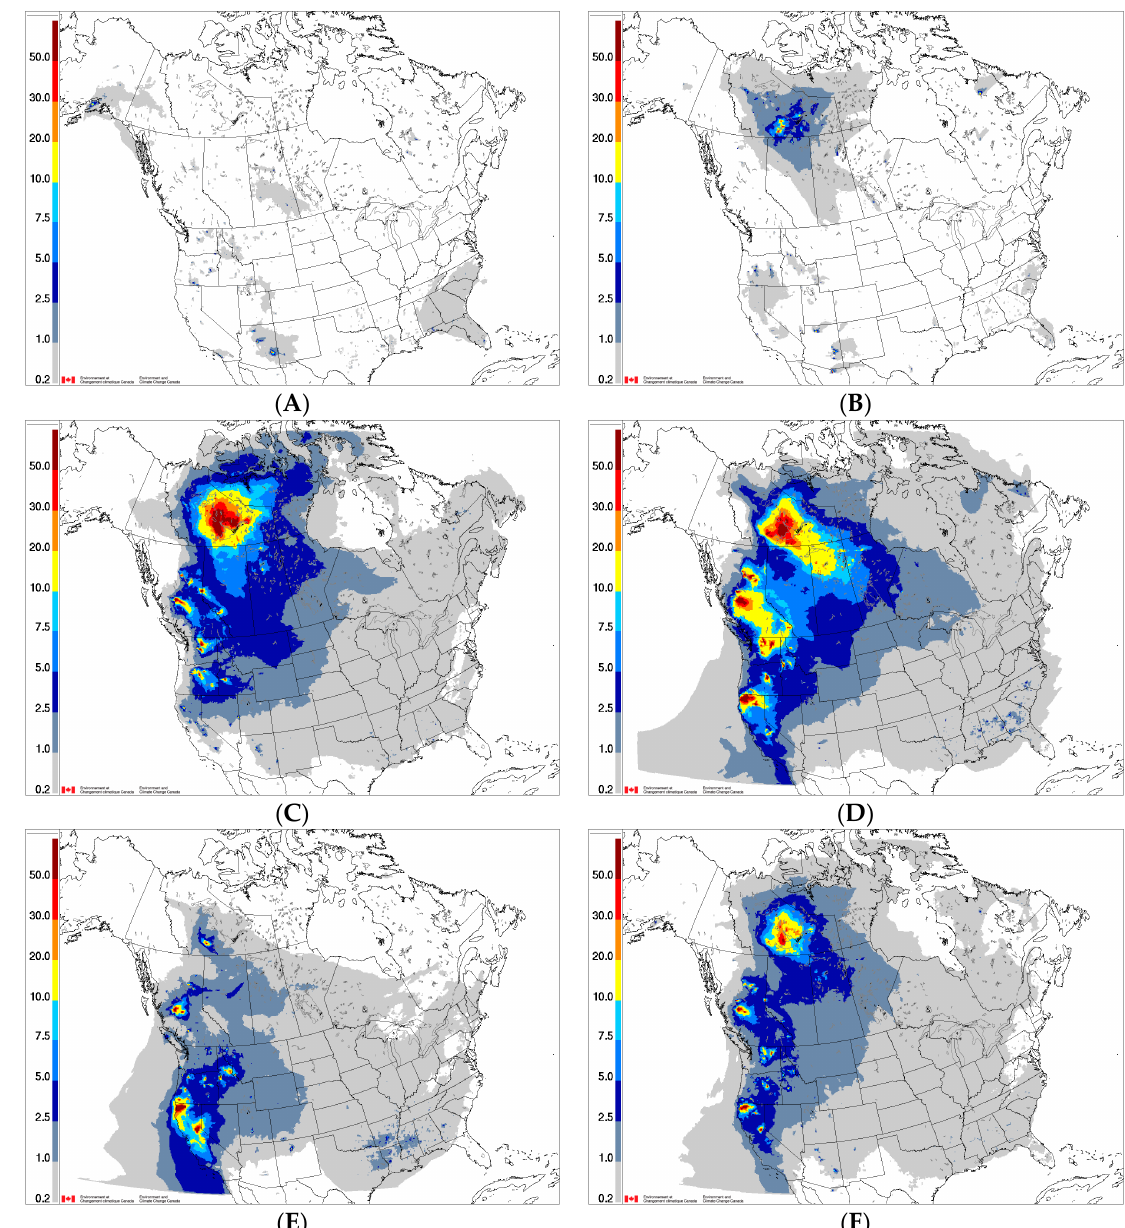
Figure 4. Same as Figure 3 but for 2014.